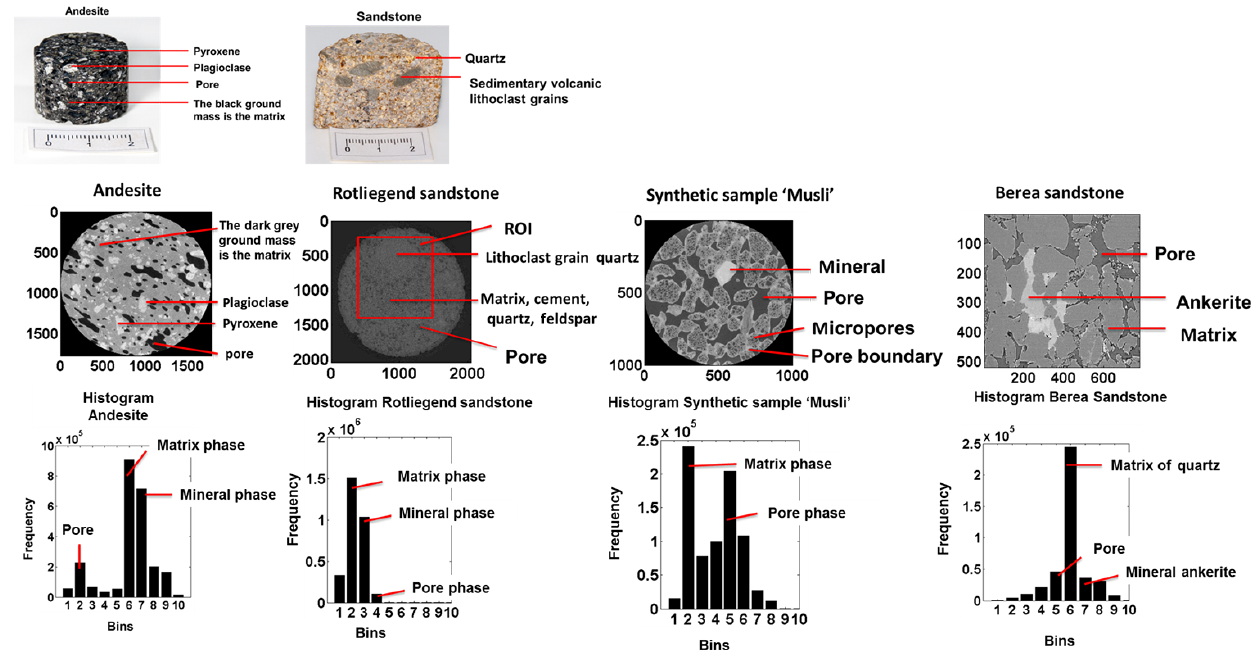
Figure 1. The top panel shows the andesite and Rotliegend sandstone rocks used for XCT measurements. Middle panel shows the raw images of andesite (16bit), Rotliegend sandstone (16bit), synthetic sample (16bit) and Berea sandstone (16bit). Mineral composition of andesite and Rotliegend sandstone was determined from thin sections using a polarized microscope. Bottom panel shows histogram plot of the respective samples. Mineral composition of Berea sandstone is based on Madonna et al. (2012) and Andrä et al.